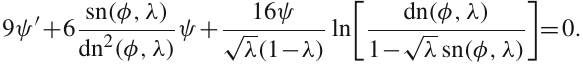
Fig. 13 Warp factor plotted for λ = 0 (thick-solid line), λ = 0 . 3 (thin-solid line), λ = 0 . 6 (dashed line) and λ = 0 . 9 (dot-dashed